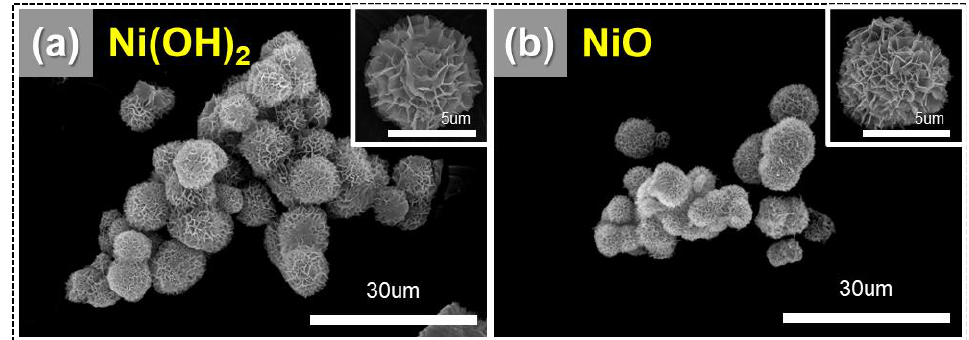
Figure 6. SEM images showing porous NiO nanostructure. ( a ) Ni(OH) 2 and ( b ) NiO.